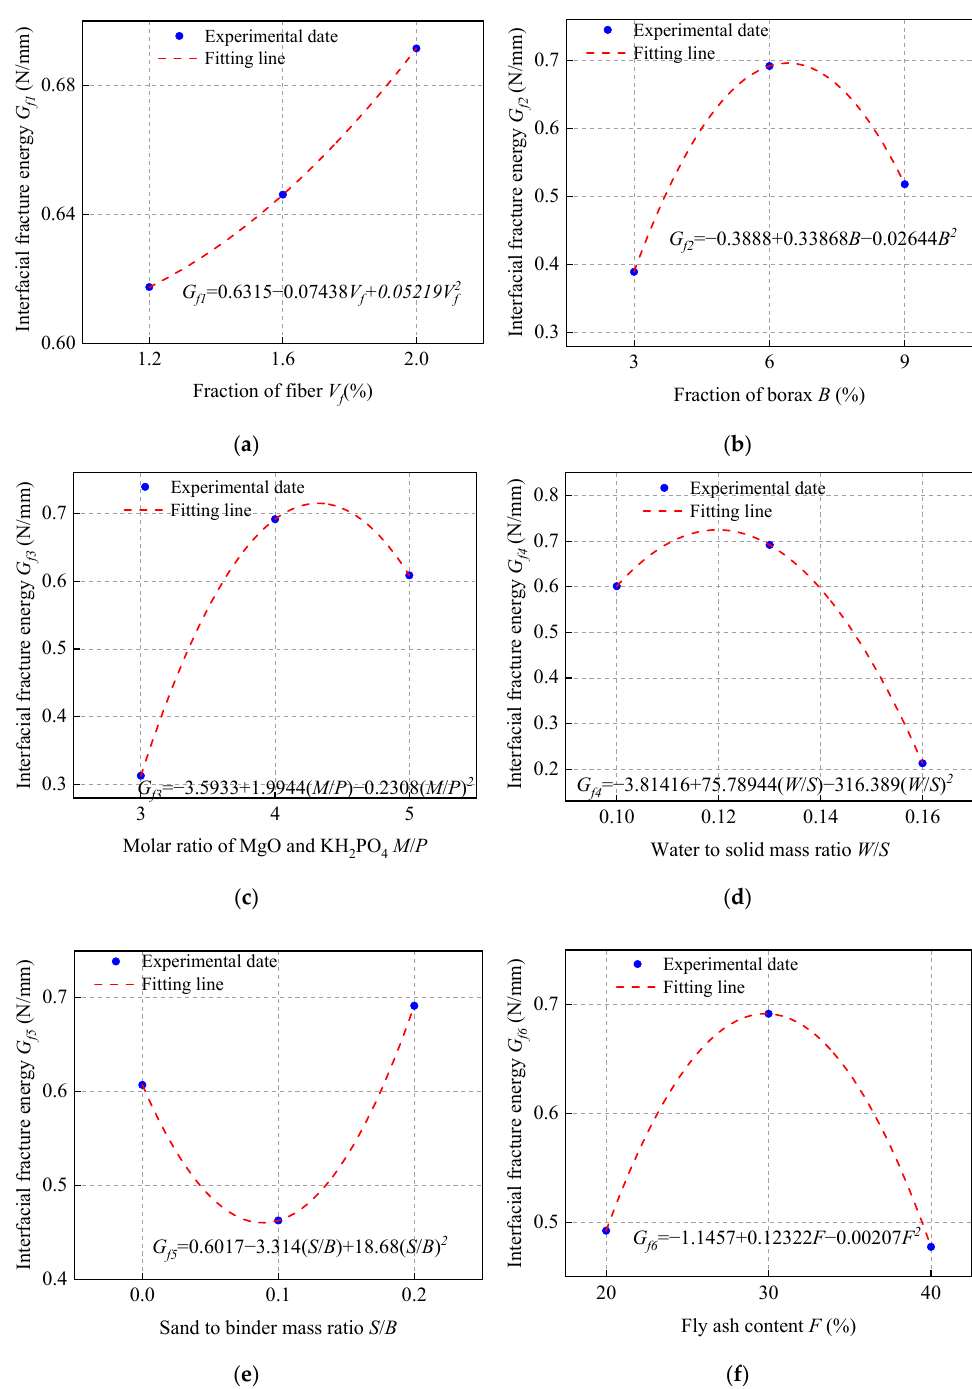
Figure 14. The fitting calculation of ( a ) S u 1 ; ( b ) S u 2 ; ( c ) S u 3 ; ( d ) S u 4 ; ( e ) S u 5 ; ( f ) S u 6 .